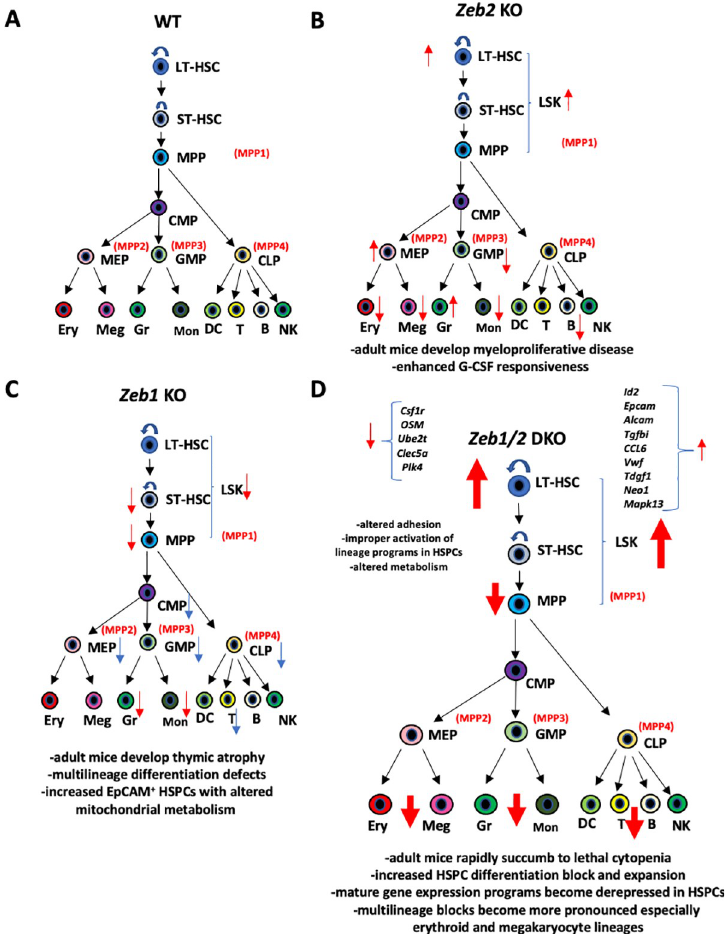
Fig 10. Summary model of effects of Zeb1, Zeb2, and Zeb1/2 double deletion on hematopoietic system development and steady-state hematopoiesis. (A) For comparative purposes, a more “classical” view of normal hematopoietic hierarchy is presented with more modern multipotent progenitor nomenclature (MPP1-4) highlighted in red. (B) Overview of Zeb2 null adult hematopoietic phenotypes previously described [9]. Adult mice develop myeloproliferative disease over time that is driven by enhanced G-CSF responsiveness [9] as well as mild differentiation defects in multiple HSPC populations including increased LT-HSCs, increased MEPs, decreased GMPs as well as defects in mature hematopoietic populations including decreased RBC, megakaryocytes, monocytes, and B cells but expanded terminal granulocyte differentiation (red arrows). (C) Represents a hybrid summary view between results of this study (red arrows) along with those found by [63] (blue arrows). Unlike Zeb2 KOs LSK, ST-HSC and MPP numbers are down in Zeb1 hematopoietic null mice and display multilineage differentiation defects with decreased numbers of progenitors and mature hematopoietic cells particularly T cells with mice developing thymic atrophy [62]. HSPC phenotype is characterized by increased EpCAM expression with altered survival and metabolism profiles. (D) Inducible loss of both Zeb1 and Zeb2 leads to acute BM failure with mice succumbing to lethal cytopenia within 2 weeks. Block in LT-HSC differentiation observed in Zeb2 KO is exacerbated in Zeb1/2 DKO settings and multilineage blocks especially in erythroid and megakaryocyte lineages are more severe (increased size of red arrows). Molecular analysis of LSK progenitors highlighting altered migratory and metabolic pathways as well as improper activation of multiple lineage-specific programs normally only observed in mature myeloid and lymphoid cell types. Specific relevant genes that are up- or down-regulated are indicated and further elaborated on in the discussion. BM, bone marrow; DKO, double knockout; G-CSF, granulocyte colony-stimulating factor; HSPC, hematopoietic stem and progenitor cell; KO, knockout; LSK, Lin − Sca1 + cKit + ; LT-HSC, long-term HSC; NK, natural killer; RBC, red blood cell; ST-HSC, short-term HSC; wt,